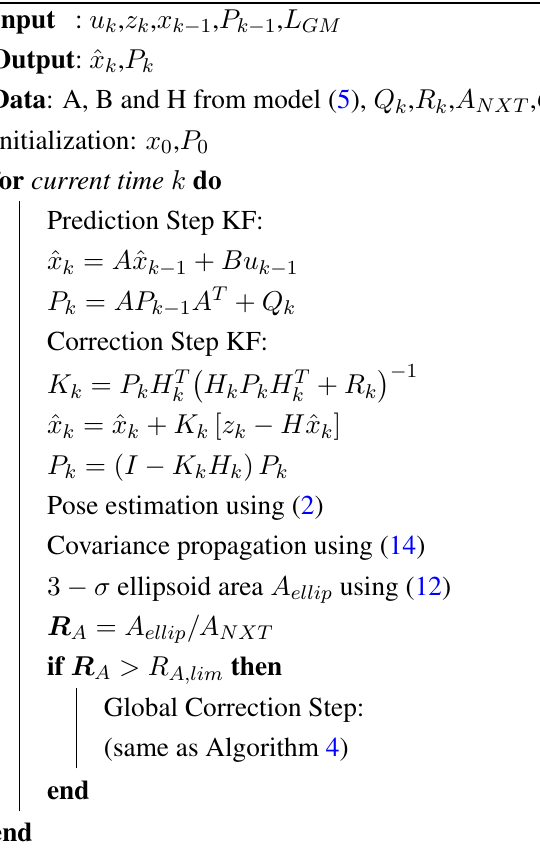
Algorithm 2: Event based KF, Differential